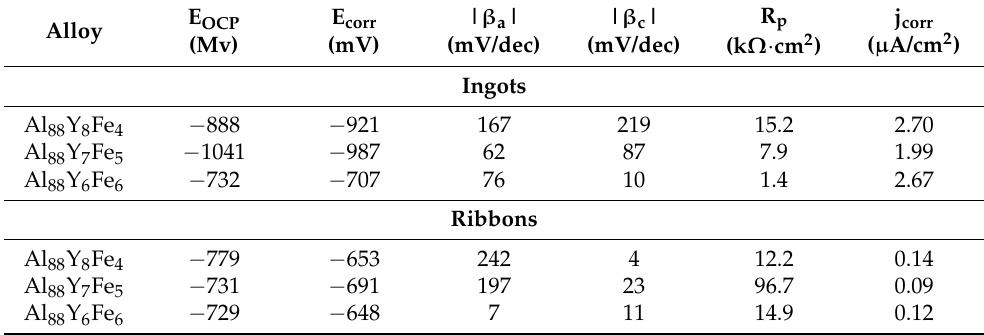
Results of polarization tests of Al-Y-Fe alloys in the form of ingots and ribbons (E OCP = open circuit potential, E corr = corrosion potential, β a , β c = anodic and cathodic Tafel slopes, R p = polarization resistance, j corr = corrosion current